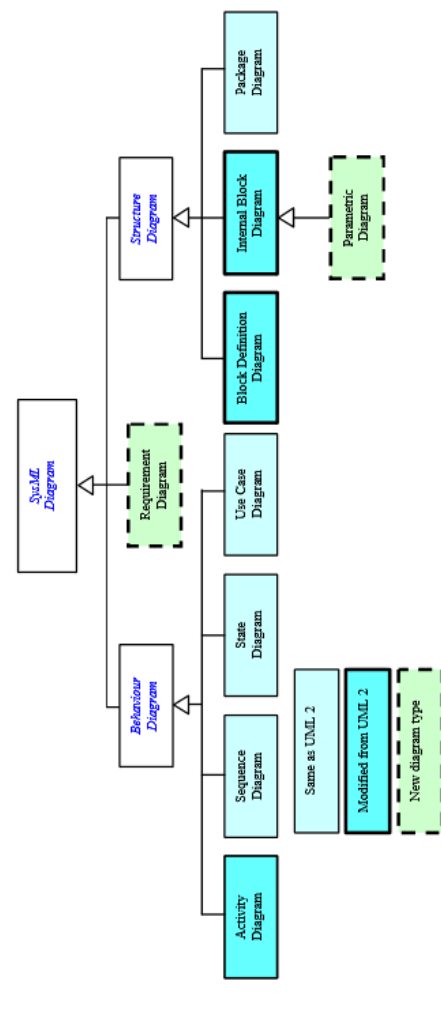
Figure 3. CSM as genesis of existing city models